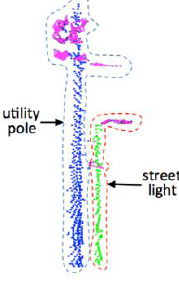
Figure 13. Pole-like objects on